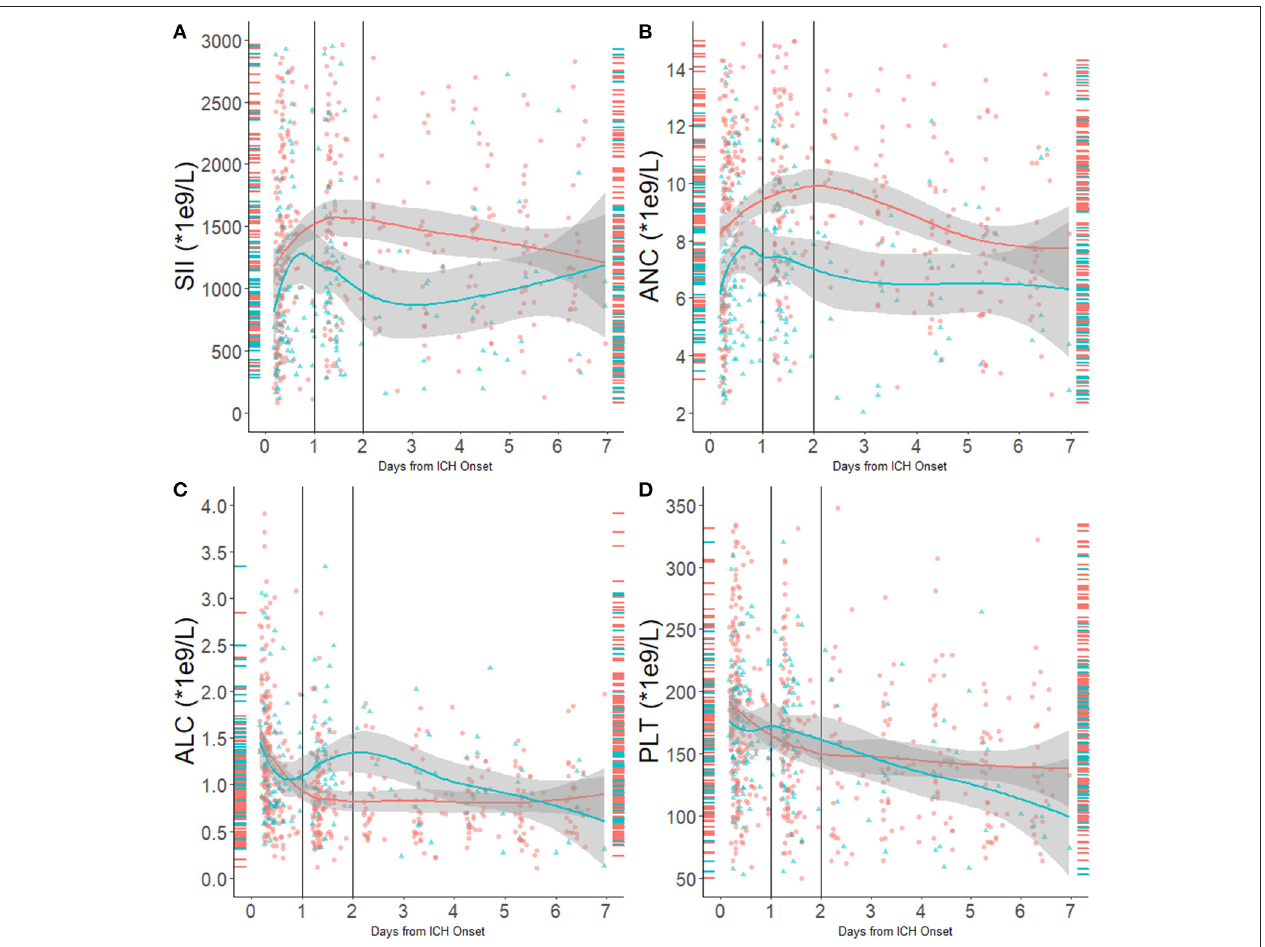
FIGURE 1 | (A) SII distribution and fitting curve according to 90-day outcome; (B) ANC distribution and fitting curve according to 90-day outcome; (C) ALC distribution and fitting curve according to 90-day outcome; (D) PLT distribution and fitting curve according to 90-day outcome. Red indicates patients with unfavorable outcomes, and blue indicates patients with favorable outcomes. Right-side rungs indicate SII distribution in the first 12h from onset; the left side indicates SII distribution 24–48h from